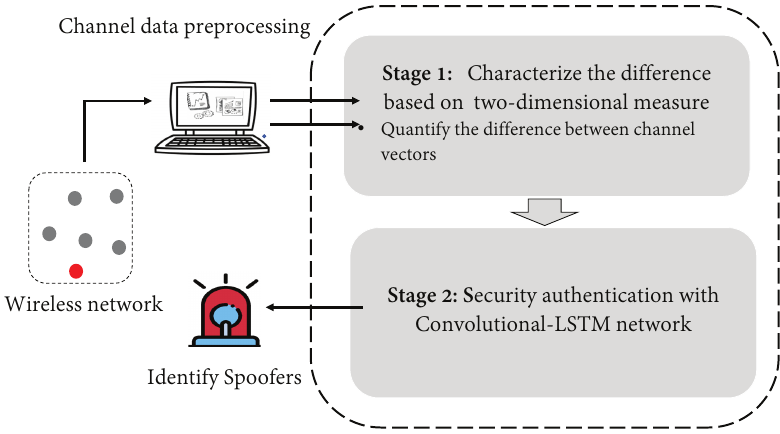
Figure 3. The architecture of the intelligent authentication